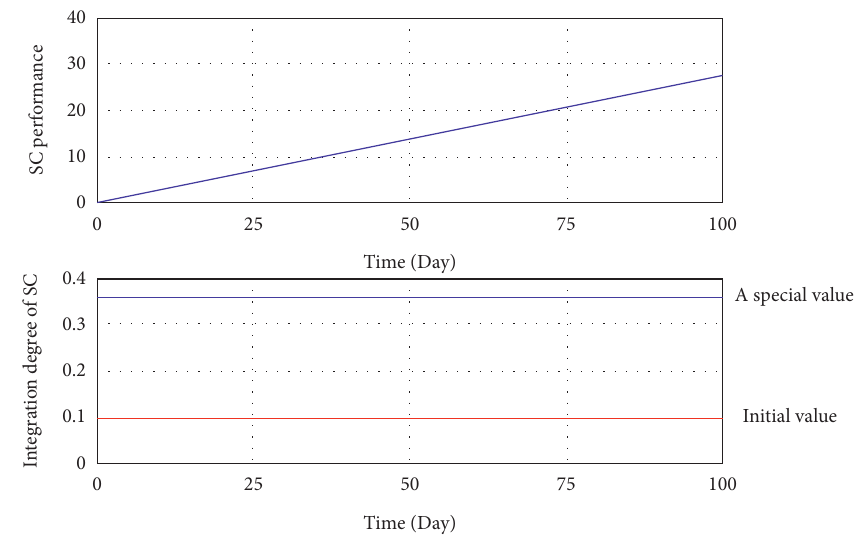
Figure 4: Effect of fixed SC integration on SC